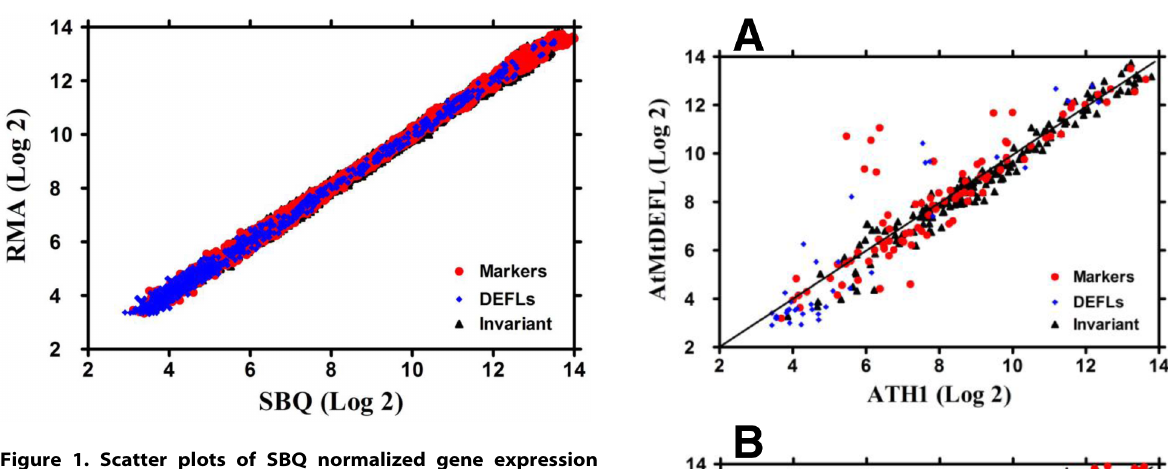
Figure 1. Scatter plots of SBQ normalized gene expression values compared to whole-array RMA across 36 ATH1 arrays. Only a subset of 299 probe sets that correspond to genes represented on the AtMtDEFL array (37 DEFLs, 171 invariants, 91 marker genes) were used for SBQ normalizations. Each was compared to the reference RMA normalization, which included all 22,810 probe sets on the Affymetrix ATH1 array in the normalization process. Expression values were log 2 transformed. All 37 probe sets on the ATH1 array that matched an Arabidopsis DEFL with at least 6 of 11 exact-match probes per probe set were included in the analysis. GEO accessions for ATH1 arrays included three biological replicates of: GSE1491 (seedlings), GSE5630 (cotyle- dons, leaves, senescent leaves), GSE5631 (roots), GSE5632 (carpels, stage 9 flowers, stamens), GSE5633 (stems), GSE5634 (old and young siliques), and GSE7227 (seeds).